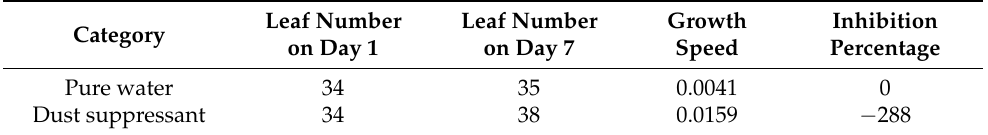
Table 7. Experimental results on plant survival rate.